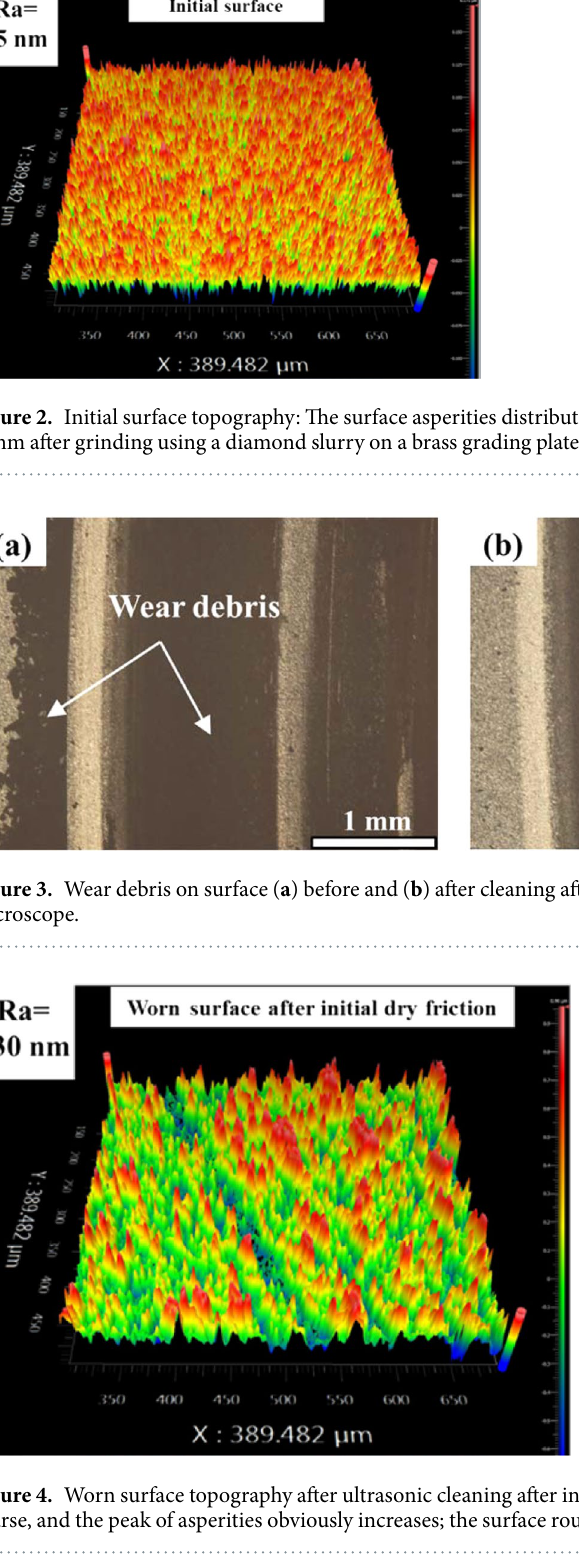
friction, there was a lot of obvious wear debris on the SiC surface shown in Fig. 3(a), comparing with the cleaning surface shown in Fig. 3(b). After the ultrasonic cleaning, the worn surface microtopography is shown in Fig. 4, it is seen that the surface is more coarse, and the peak of asperities obviously increases; and the surface roughness is 230 nm.